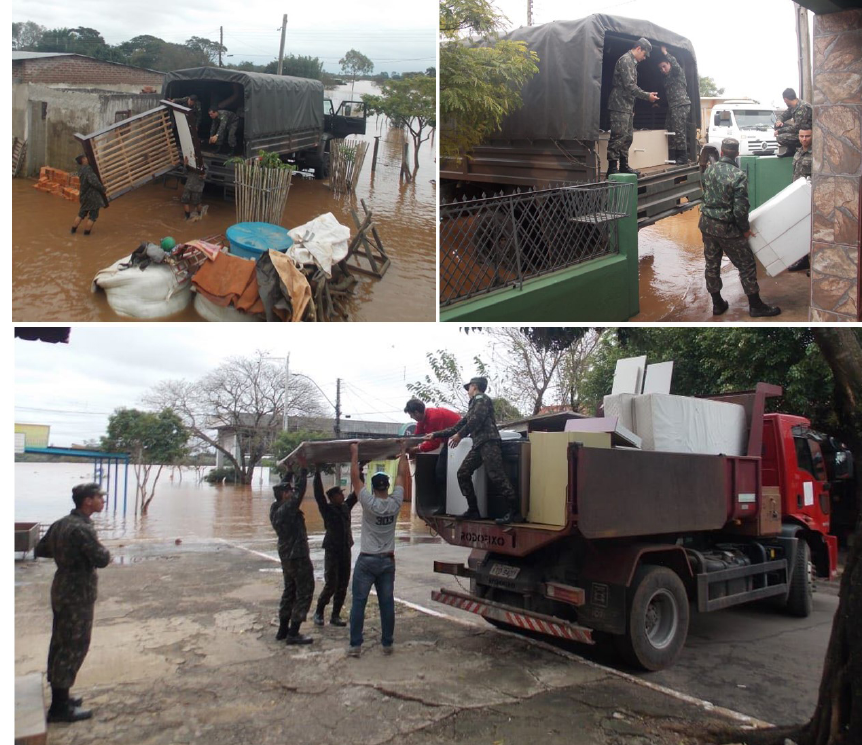
Figure 3. The Brazilian Army helping local residents during flooding events in Itaqui (adapted from: EB,